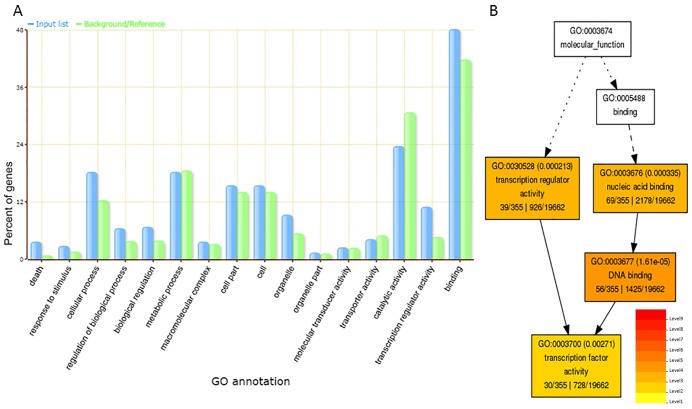
GO analysis of targets of conserved, variants of conserved and novel tomato miRNAs using singular enrichment analysis tool (SEA) of AgriGO toolkit.(A) The percentage of genes mapped under different GO terms is represented through a bar graph. Blue bars indicate percentage of enriched miRNA target genes in different GO terms and green bars indicate percentage of total annotated tomato genes mapping in different GO terms. (B) Enriched GO terms in molecular function category are represented in hierarchical tree graph.